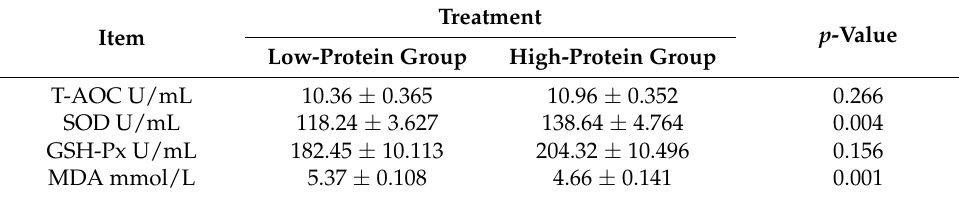
Table 5. Effects of the dietary protein level on the plasma antioxidant indexes of growing yaks.